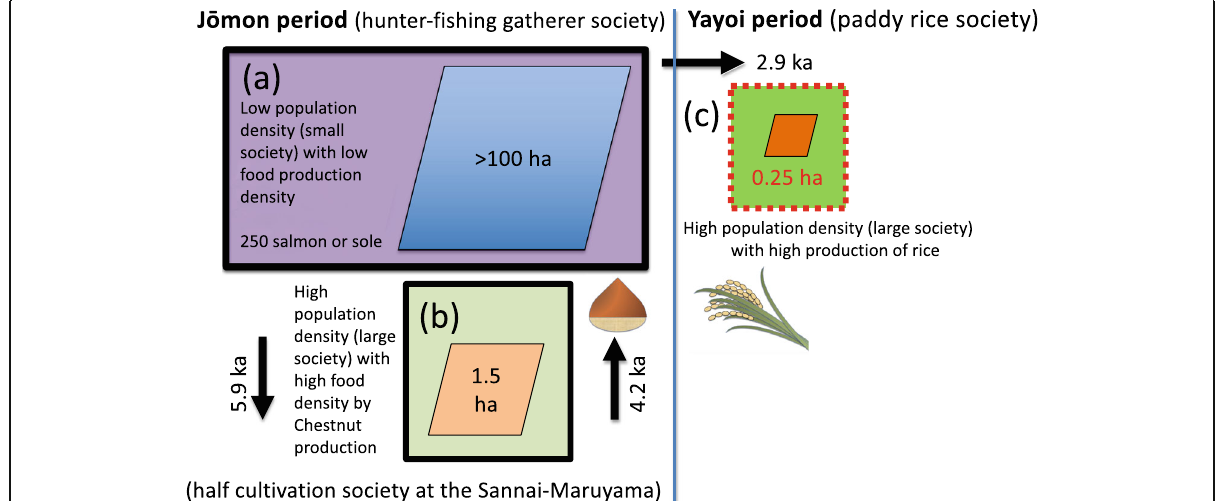
Fig. 4 Schematic diagram showing the area required for total calories (7.3 × 10 5 kcal/year) to support one person per year. a Hunter-fisher- gatherer societies in the J ō mon era generally required larger areas (more than 100 ha (1 km 2 )) due to low production density. In contrast, b chestnut production by hansaibai could require only 1.5 ha due to high production density in J ō mon era. This value is only sixth times that (0.25 ha) required by rice production in the Yayoi era ( c ). Thick black of outer frame lines represent the J ō mon society while the red dotted lines represent the Yayoi society. Green squares represent high production density ( b , c ) while purple squares show low production density ( a ). In general, J ō mon societies were characterized by low population density due to low food production density. In contrast, high production density of chestnut by hansaibai influenced by warm climate allowed the settlement of the Sannnai-Maruya site at 5.9 cal. kyr BP ( b ) while cool climate would have eventually collapsed the site at 4.2 cal. kyr BP, resulting in the dispersal of the population to smaller communities ( a ). Paddy rice- based societies in association with villages started at 2.9 cal. kyr BP in western Japan ( c